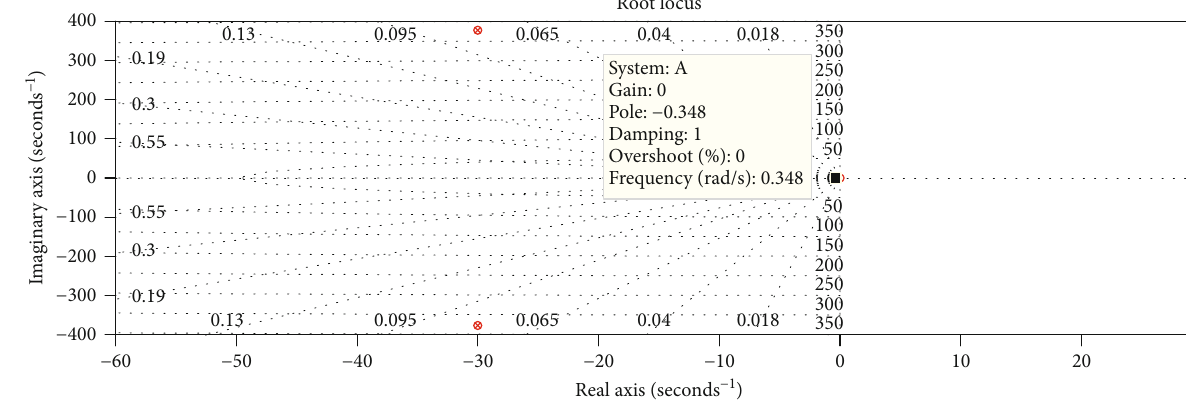
Figure 11: Root locus for the classical ESC